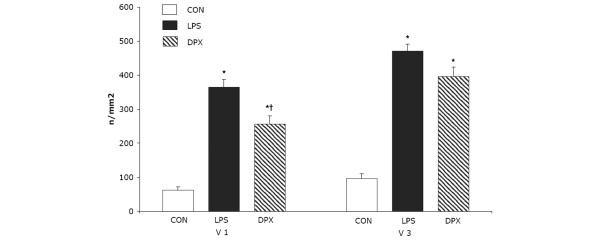
Firmly adherent leucocyte count. Shown are the counts of firmly adherent leucocytes (sticker) in V1 and V3 venules; measurements were taken two hours after endotoxin challenge. CON, control group; DPX, DPX group, (endotoxin plus dopexamine); LPS, LPS group (endotoxin infusion only). *P < 0.05 versus CON; †P < 0.05 versus LPS.